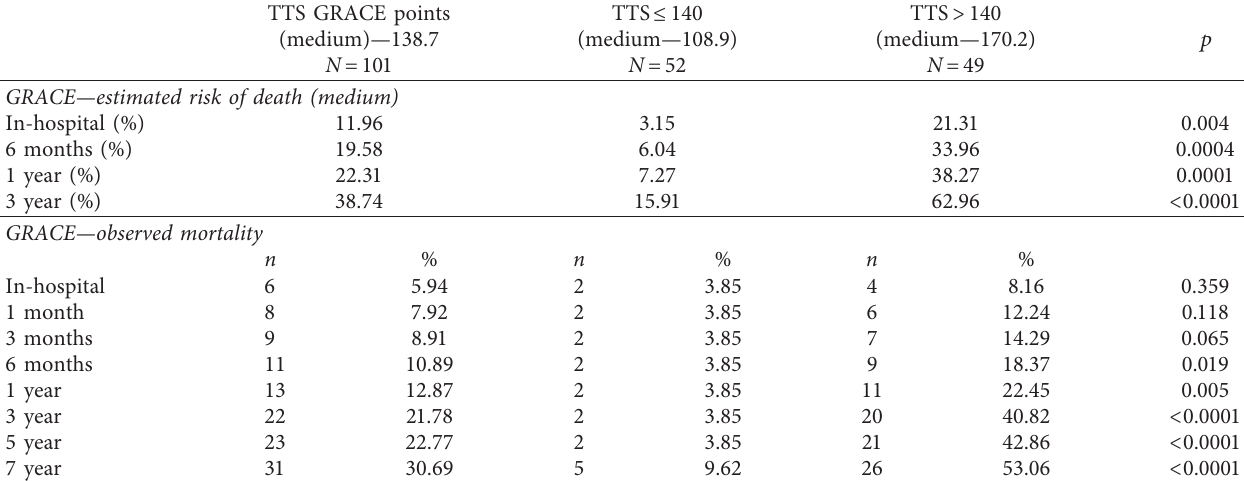
Table 2: Results—comparison of estimated and observed mortality of 2 Takotsubo groups ( n �